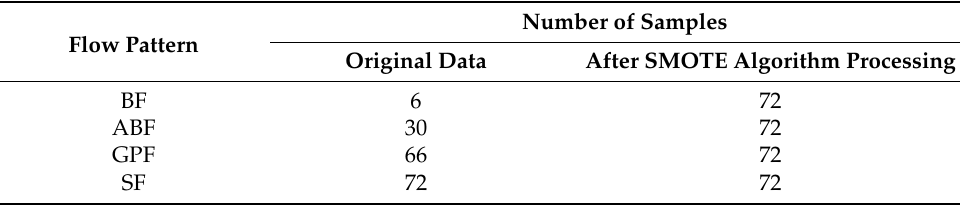
Table 5. Description of training data set before and after data enhancement. Number of Samples Flow Pattern Original Data After SMOTE Algorithm Processing BF